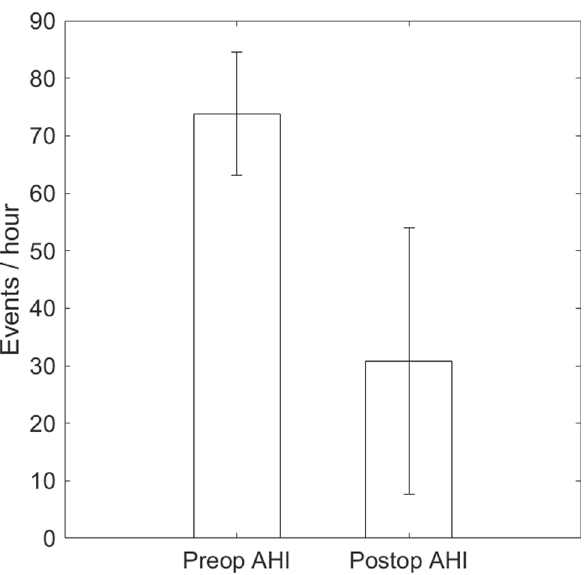
Figure 1. Mean and standard deviation of apnea–hypopnea index (AHI) reduced from 73.8 ± 10.7 to 30.8 ± 23.2 events/h after the